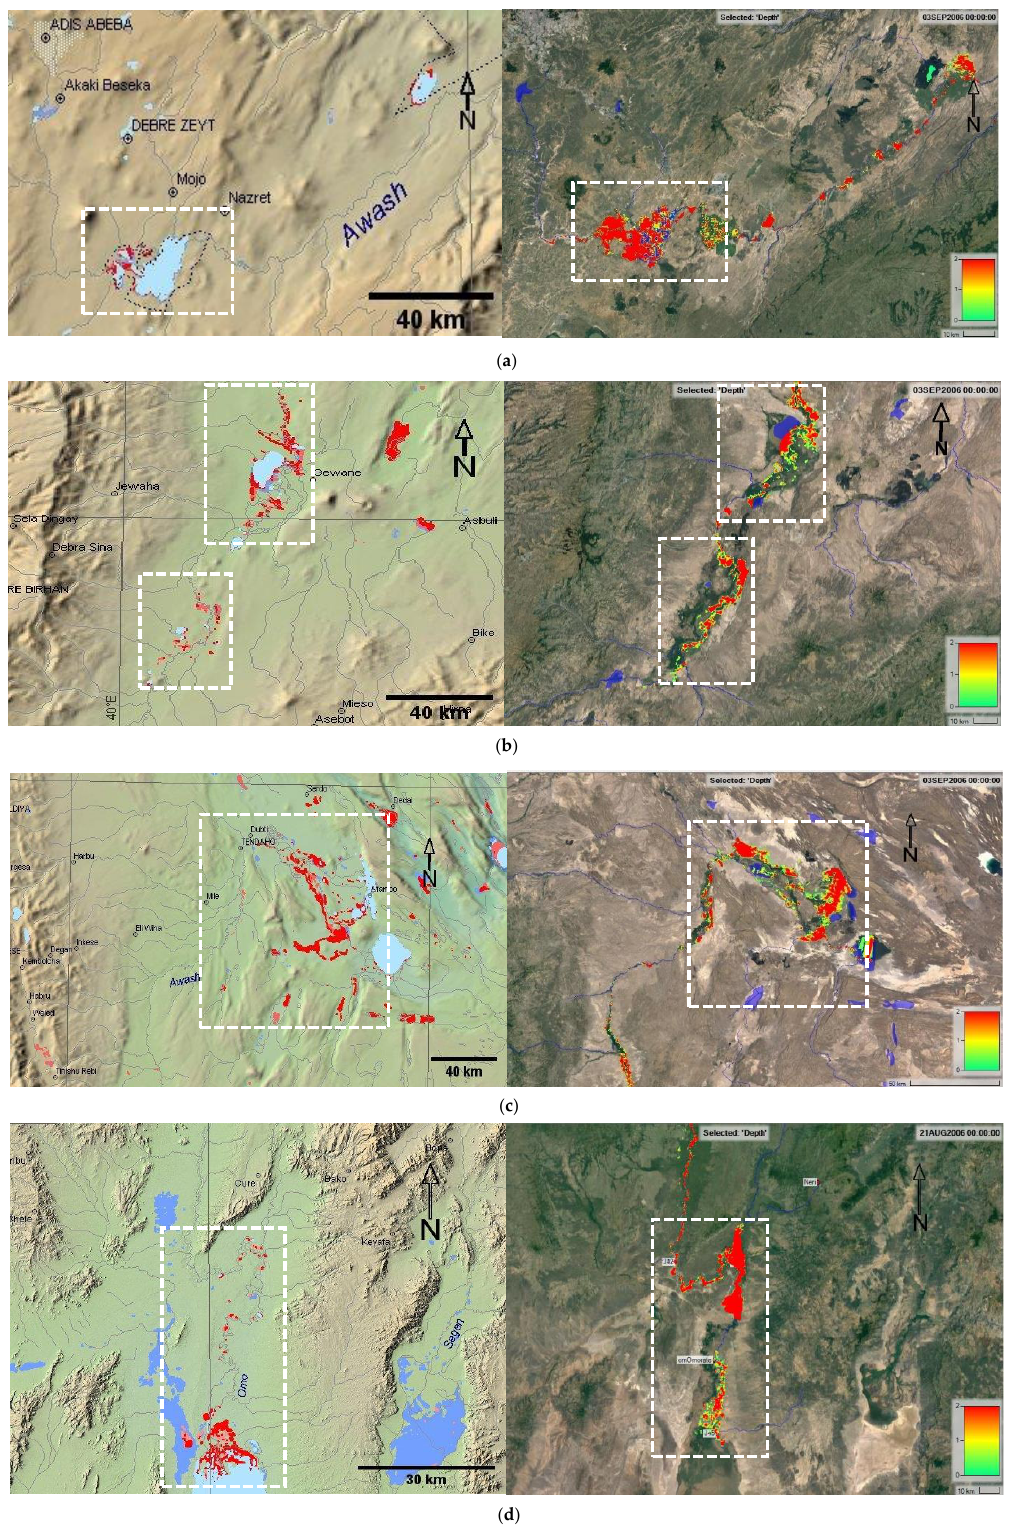
Figure 7. Satellite observation from DFO (left) and model inundation maps (right) in 2006 excluding lake areas, where ( a ) presents the flood inundation maps in upper Awash (on 3 September 2006); ( b ) presents the flood inundation maps in middle Awash (on 3 September 2006); ( c ) presents the